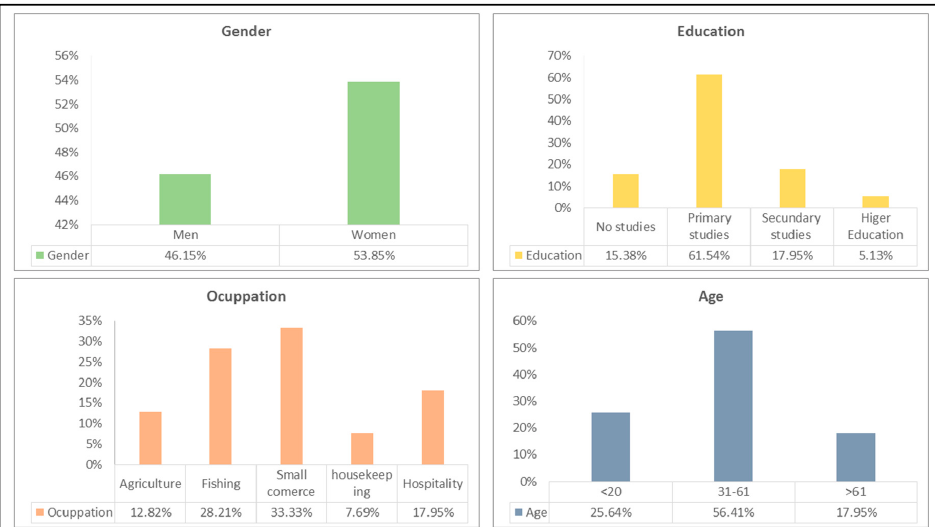
Figure 3. Graphic description of the socioeconomic characteristics of the surveyed population. The results are indicated in percentages according to gender, educational level, occupation, and age.